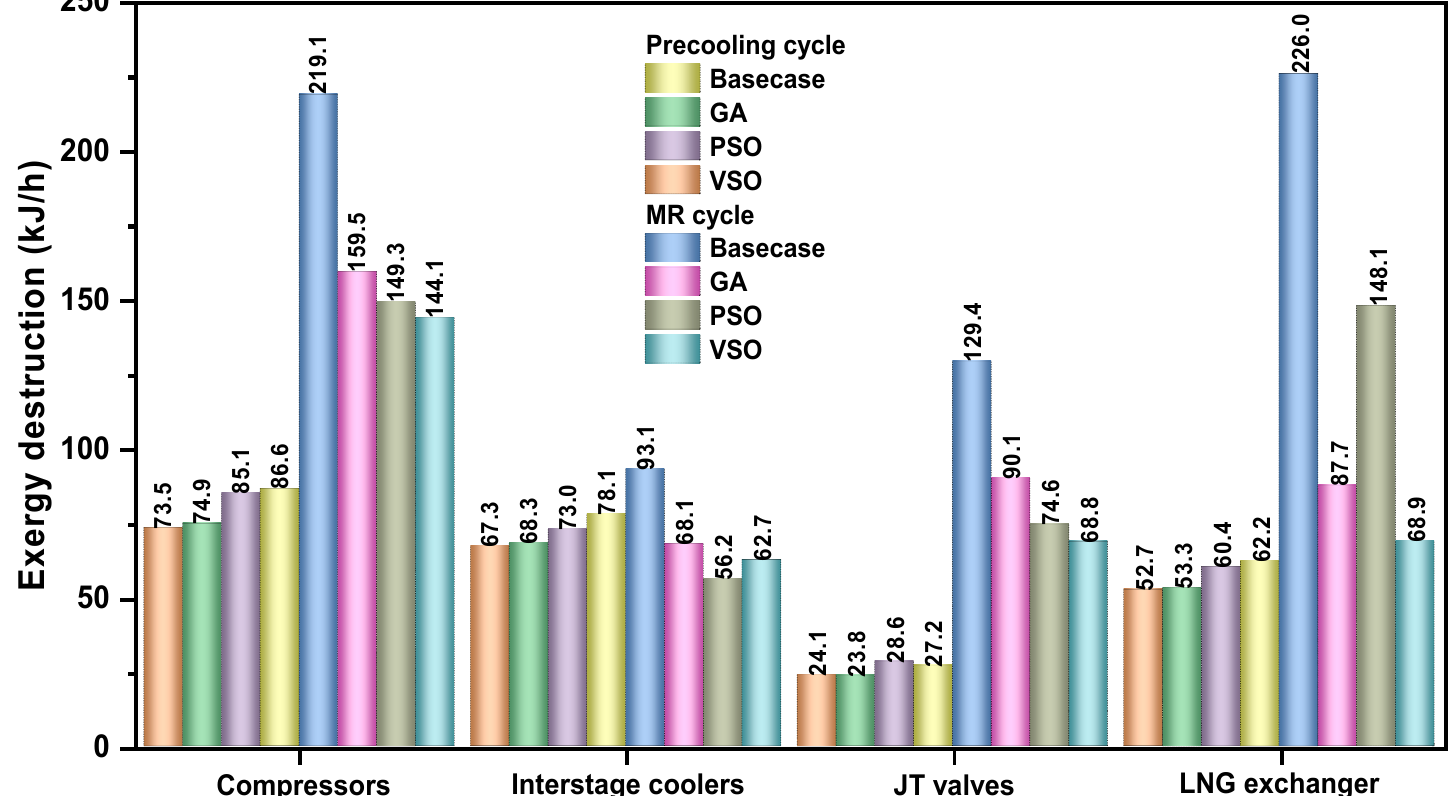
Figure 8. Exergy destruction associated with each equipment of the optimized C3MR process.